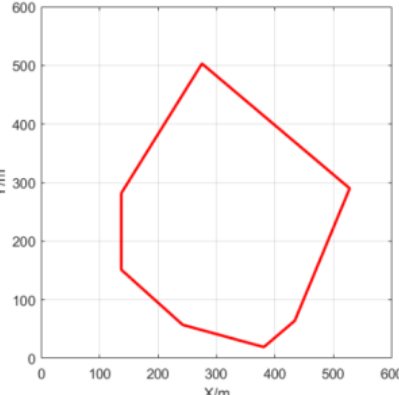
Figure 3. Area map 1 in a simulation environment.